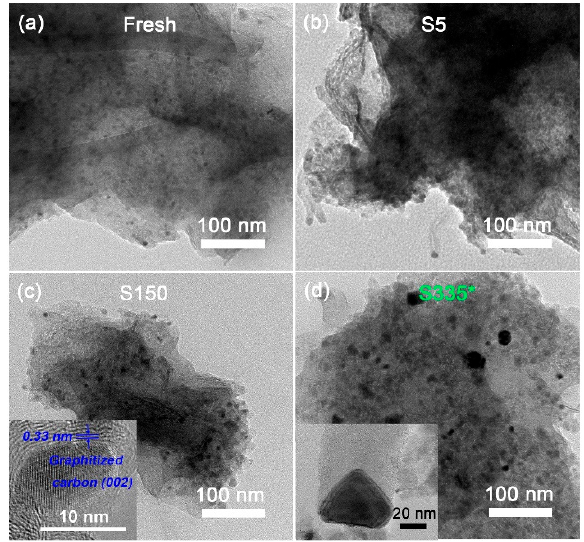
Figure 8. TEM images for the fresh and spent Ni/MgAl 2 O 4 -E catalyst: ( a ) fresh catalyst, ( b ) after reaction for 5 h, ( c ) after reaction for 150 h, and ( d ) after reaction for 335 h followed by regeneration and reaction for 24 h.